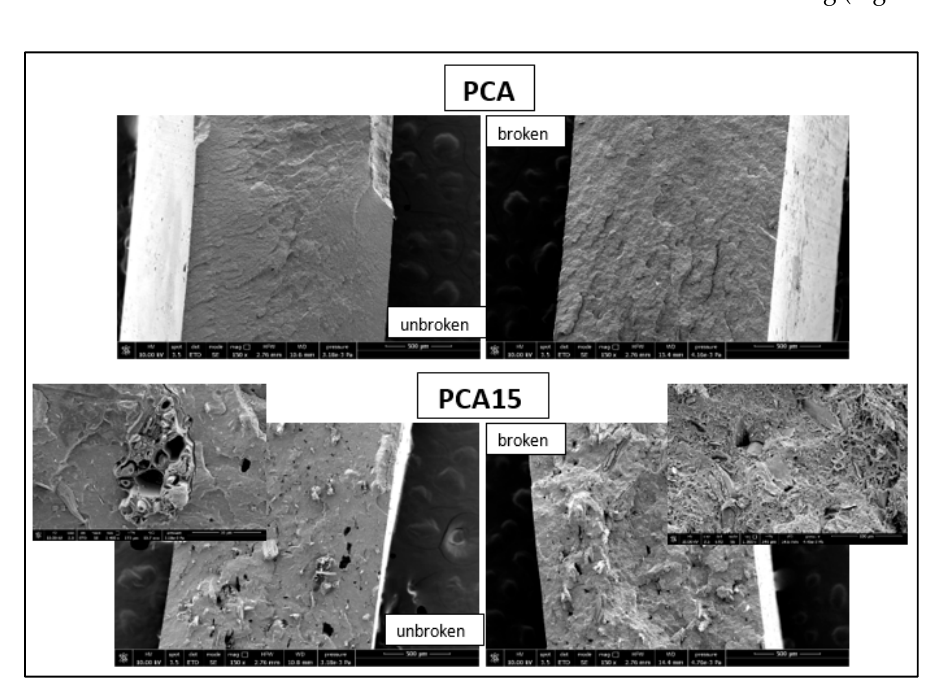
Figure 3. SEM images of the cross-sections of the PCA and PCA15 specimens before (unbroken samples) and after tensile tests (broken samples).